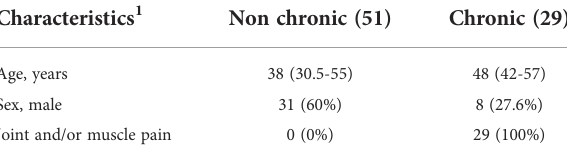
TABLE 2 Characterization of the population regarding the symptoms presented after 1 year of diagnosis.